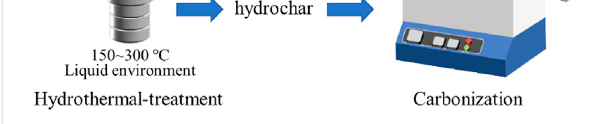
FIGURE 2 Typical procedure for hydrothermal treatment combined with